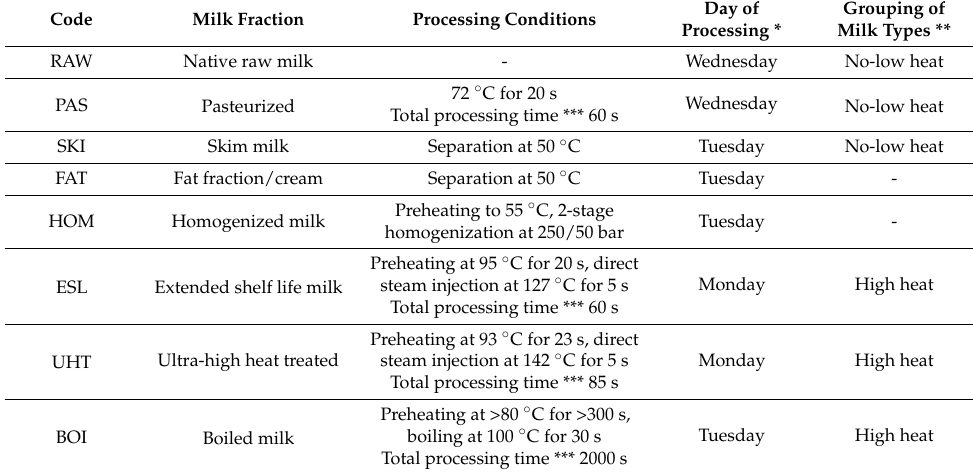
Table 2. Processing details of the milk